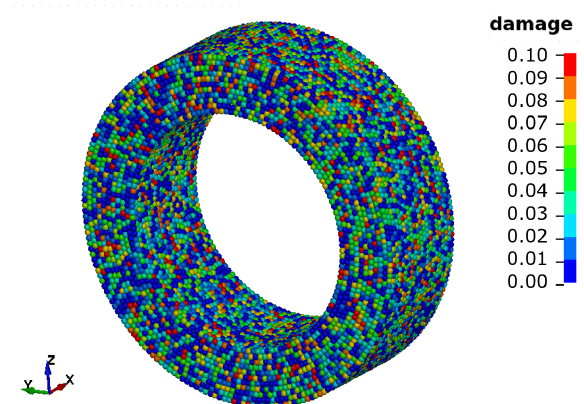
Figure 6. Initial damage distribution for an aspect ratio of 2:1 and D 0,max =